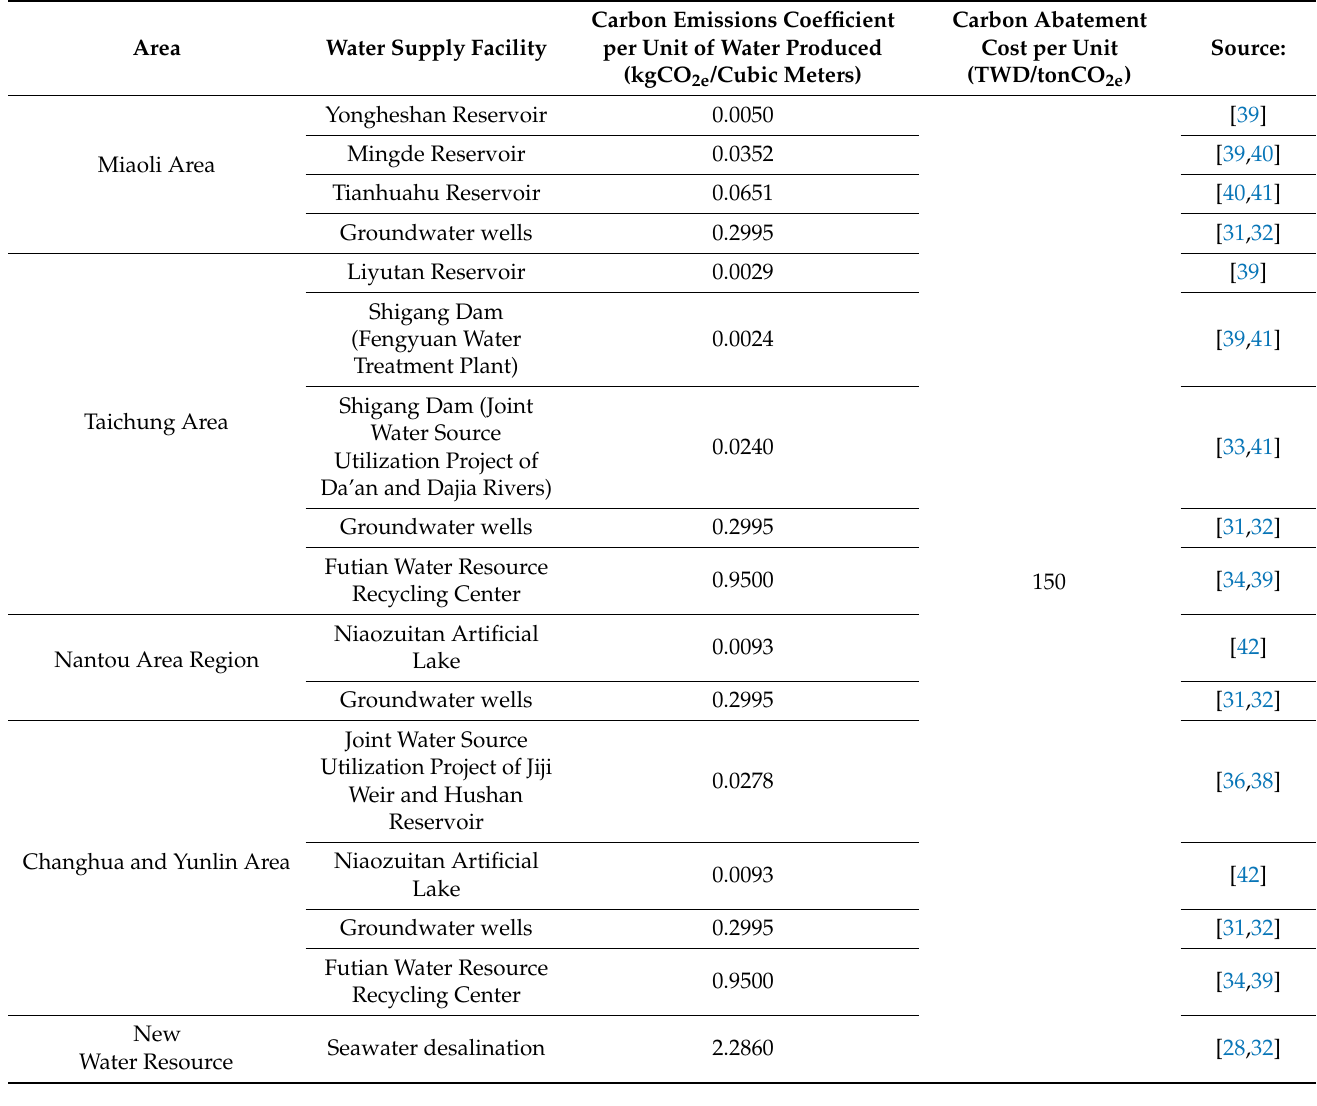
Table 4. Carbon Emissions per cubic meters of Water Produced and Carbon Abatement Cost per ton.